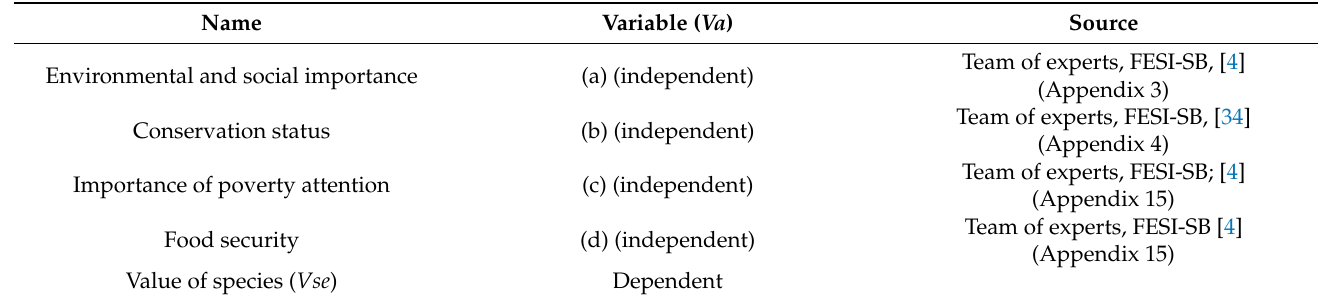
Table 1. Environmental and socioeconomic variables used in the indicator